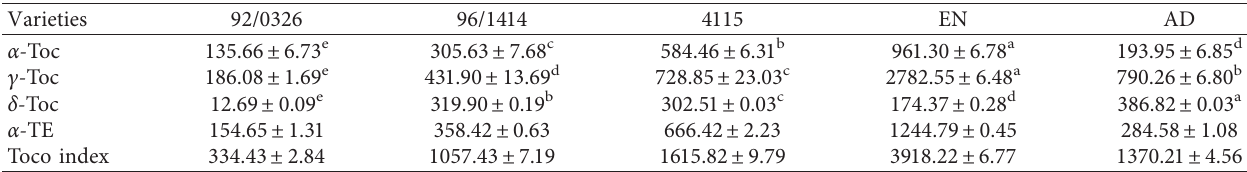
Figure 1: Total vitamin E of edible cassava leaf variety at different harvest ages. Values are given in micrograms per gram of sample dry weight ( μ g/gdw); MAP: months after planting. Cassava leaves varieties were harvested at 6MAP (onset of dry season, 15–20 ° C, 00 mm), 9MAP (main dry season, 35–40 ° C, 00mm), 12MAP (onset of rainy season, 20–30 ° C, 300–500mm), and 15MAP (rainy season, 15–25 ° C, 9500–1100mm) months after planting. Values are expressed in microgram tocopherol equivalent per gram dry weight basis ( μ g α -TE/gdw). Values are mean ± standard deviation; n � 4; bars followed by different lowercase letters are significantly ( p < 0 . 05) different for the same harvest age. Two-way ANOVA: variety ( p value � 0.040); MAP ( p value � 0.000); variety × MAP ( p value � 0.731). Table 1: Tocopherol isomers content of edible cassava leaf variety harvested in onset of dry season at 6 months after planting (6MAP, 15–20 ° C, 00mm).